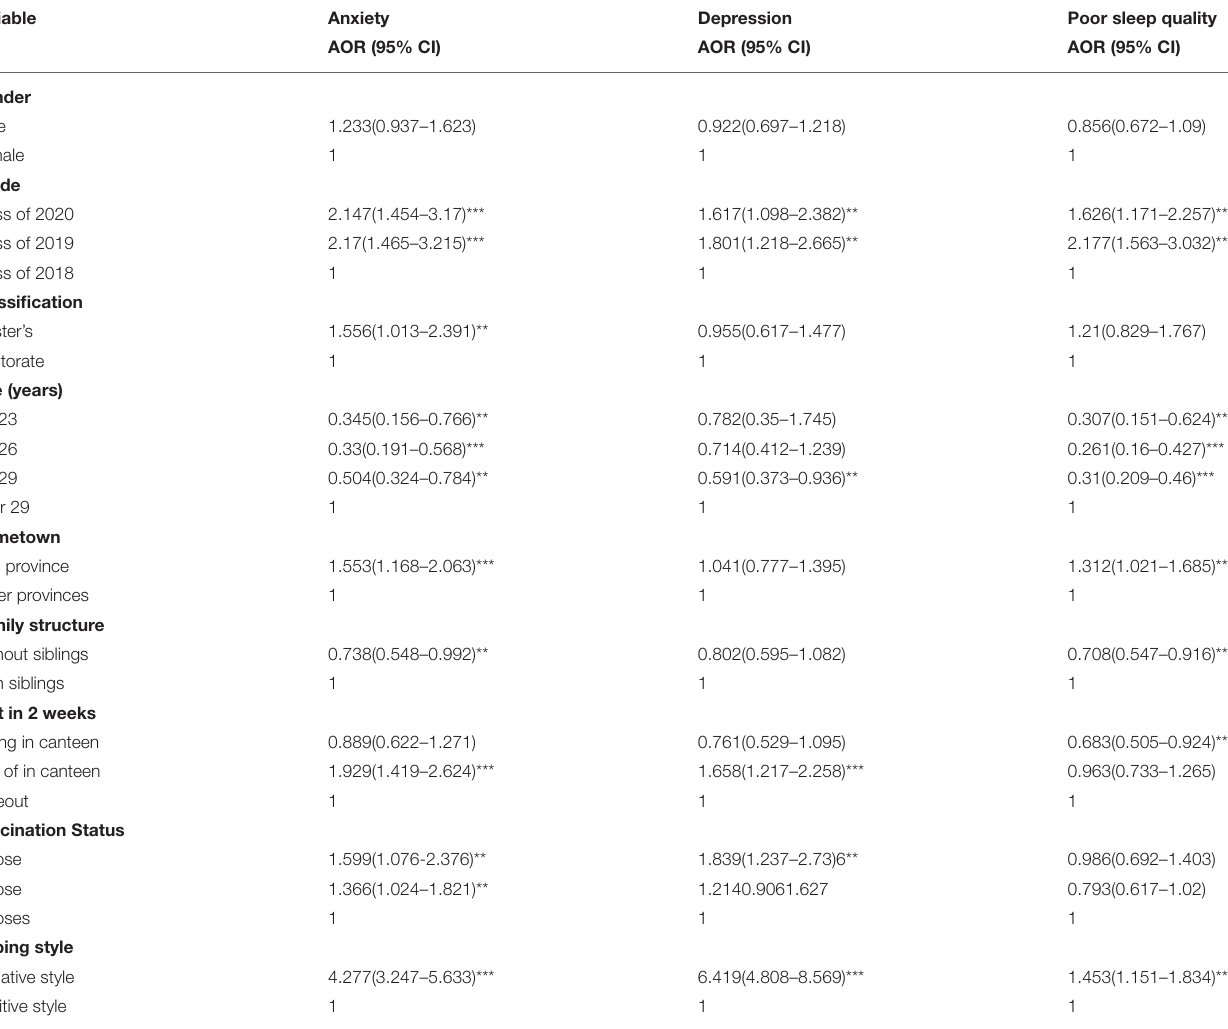
TABLE 3 | Factors associated with probable anxiety, depression and sleep quality problem using multivariate logistic regression analyses among 1,336 Chinese medical